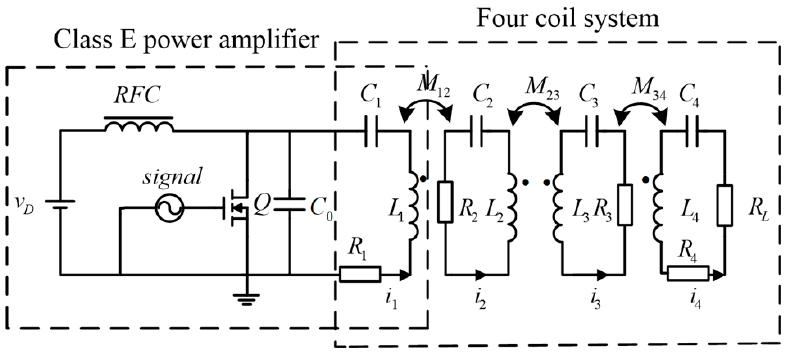
Figure 1. Circuit schematic of the proposed wireless power transfer (WPT) system.